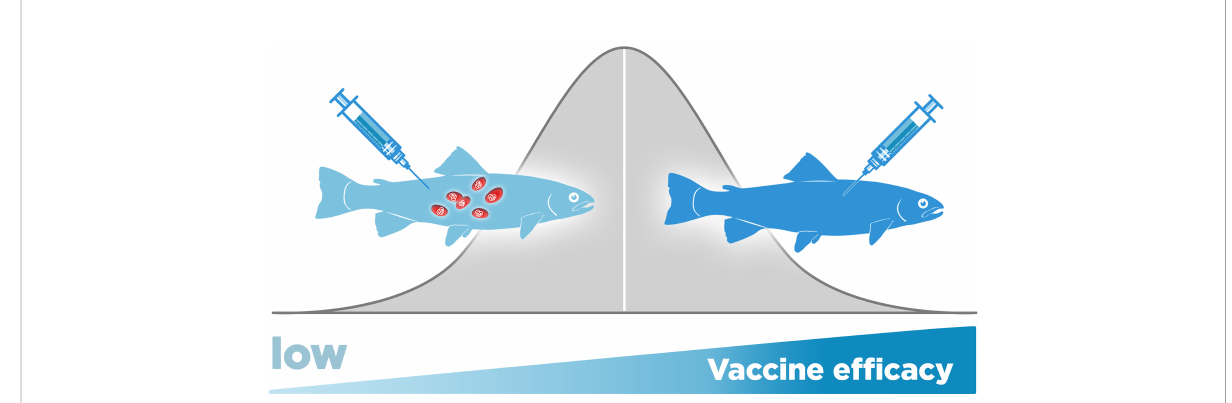
FIGURE 6 Piscirickettsia salmonis vaccine ef fi cacy in salmonids is in fl uenced by host genetic variation. While in some fi sh, the protection added by vaccination increased the survival and reduce the bacterial load (right fi sh) in other, there is no added protection by vaccination (left fi